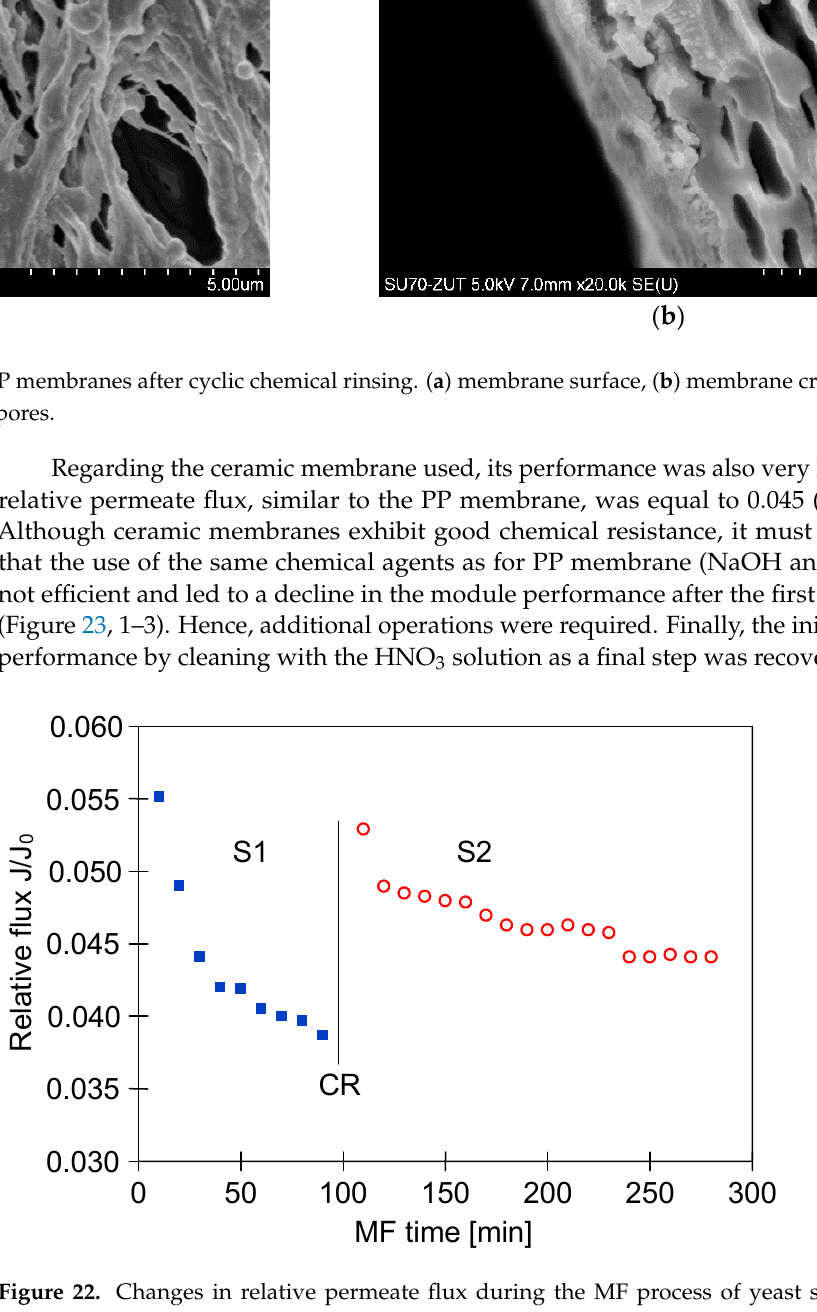
periodically cleaning the module. Module M4, TMP = 0.08 MPa, V F = 5.5 m/s, CR—chemical